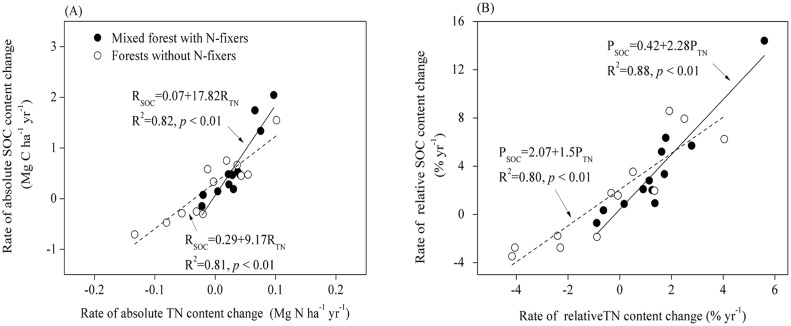
Patterns in SOC and TN content at 0–20 cm in tree-dominated afforestation systems.(A) Rates of absolute change in SOC and TN content; (B) Rates of relative change in SOC and TN content. The solid line indicates mixed forests with N-fixers and the dashed line indicates forests without N-fixers.